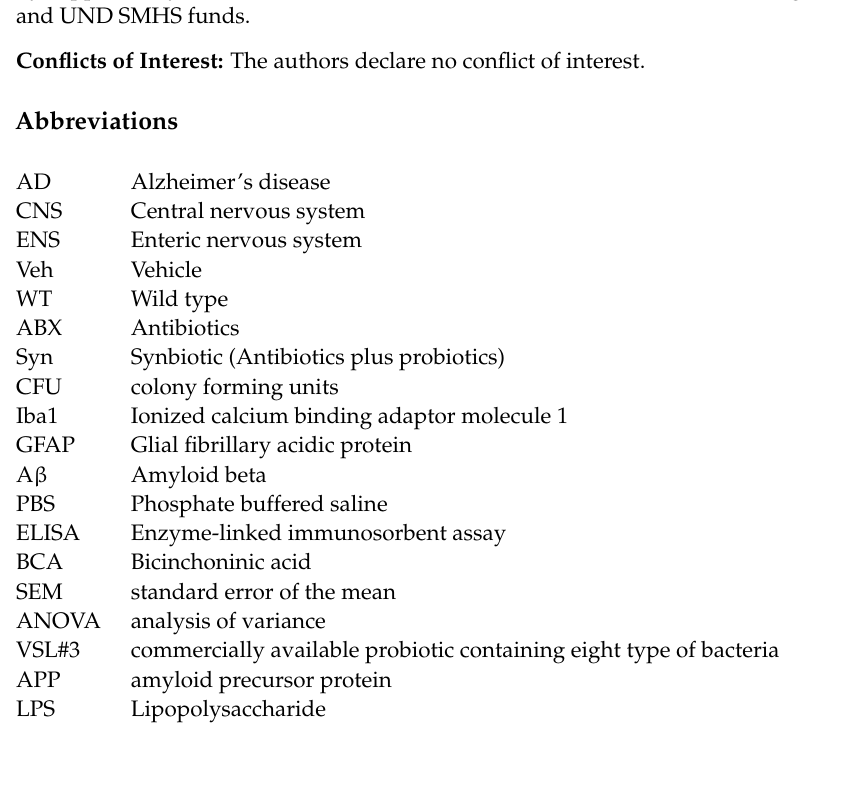
Figure S4: Quantification of Th1, Th2, and Th17 cytokines in the serum of male C57BL/6J (WT) and App NL-G-F